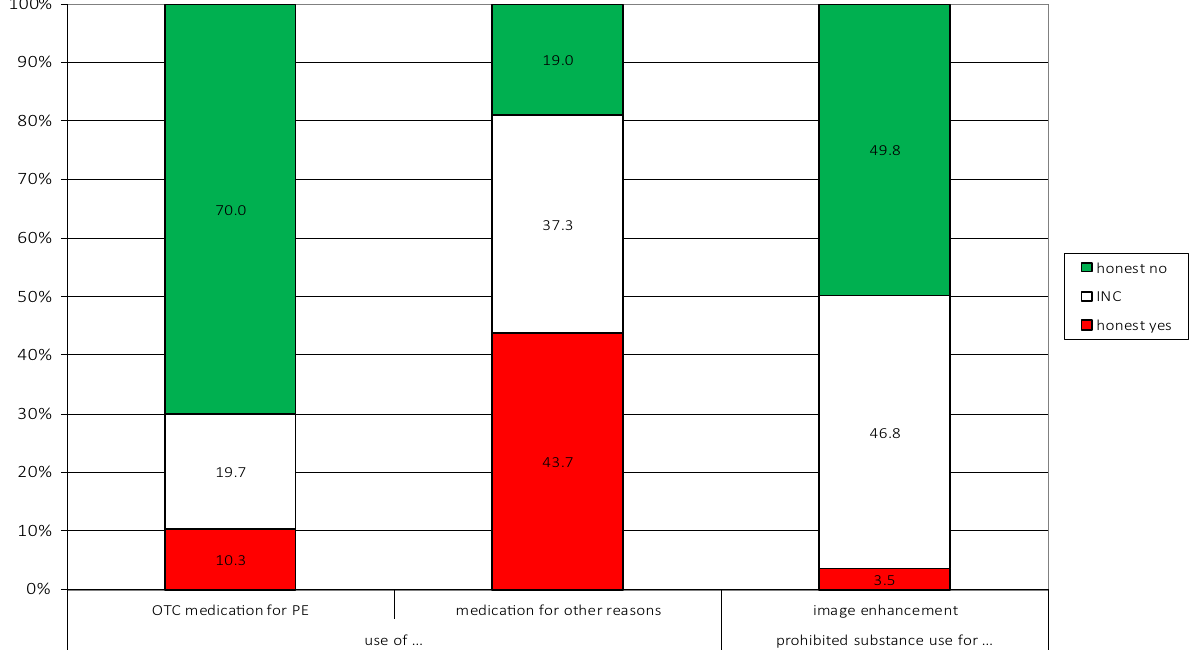
Fig. 4 Estimates for the use over-the-counter medications performance enhancement (left), use of medication for training or for competition for purposes other than performance enhancement (center) and for the use prohibited substances or methods to enhance image (right). INC Instruction Non-Compliance, OTC Over-The-Counter, PE Performance = = =